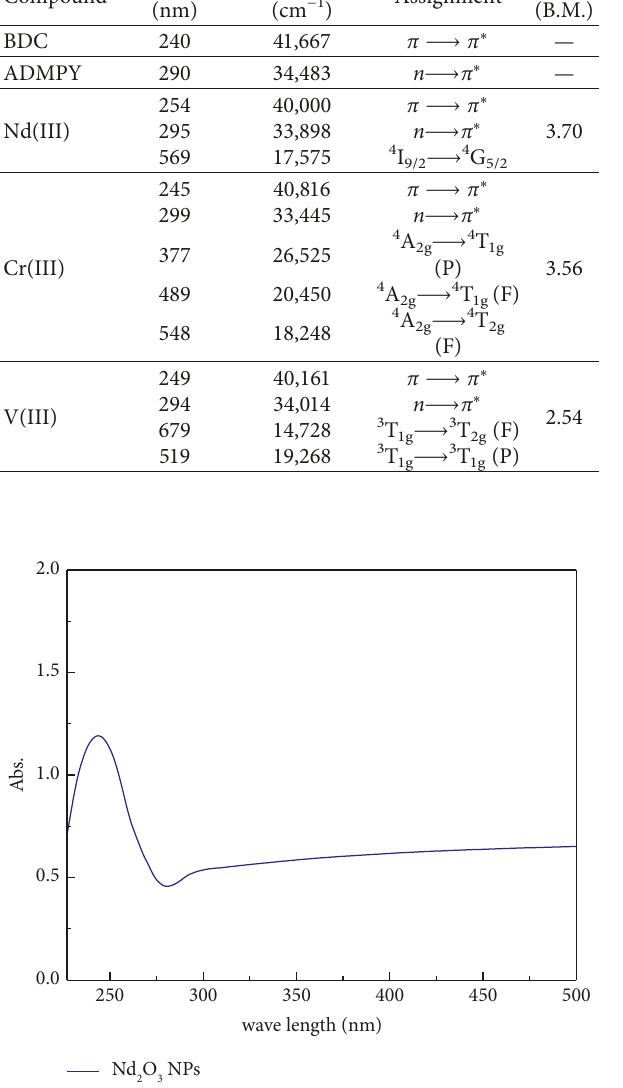
Figure 4: UV-Vis spectrum of V